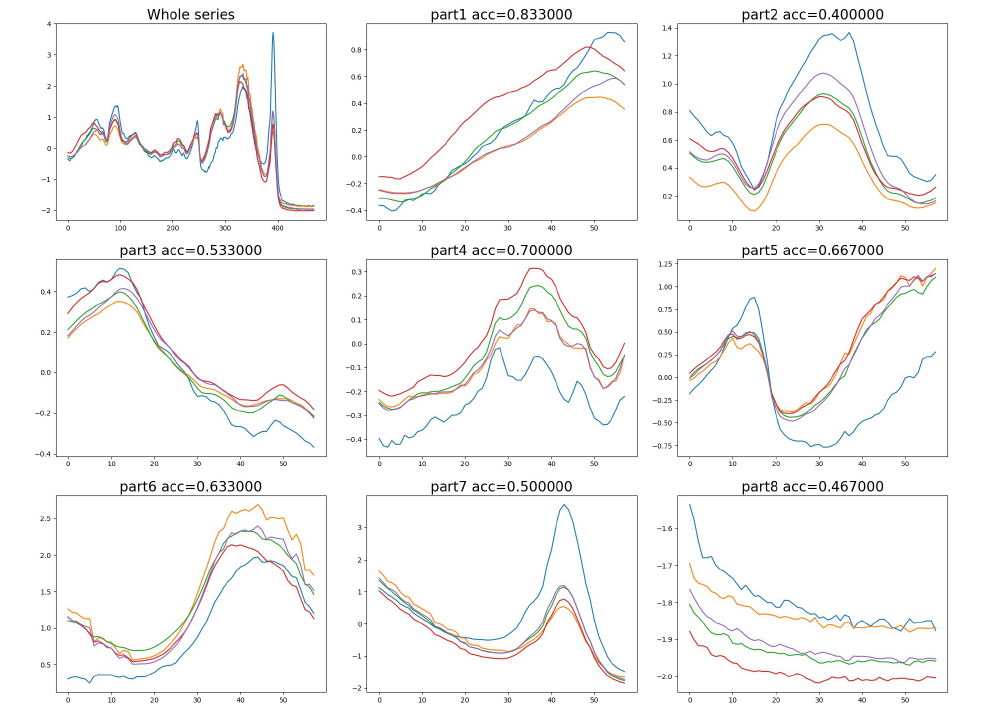
Figure 5. Curves of time series instances of Beef dataset and the corresponding accuracy given by candidates evaluation